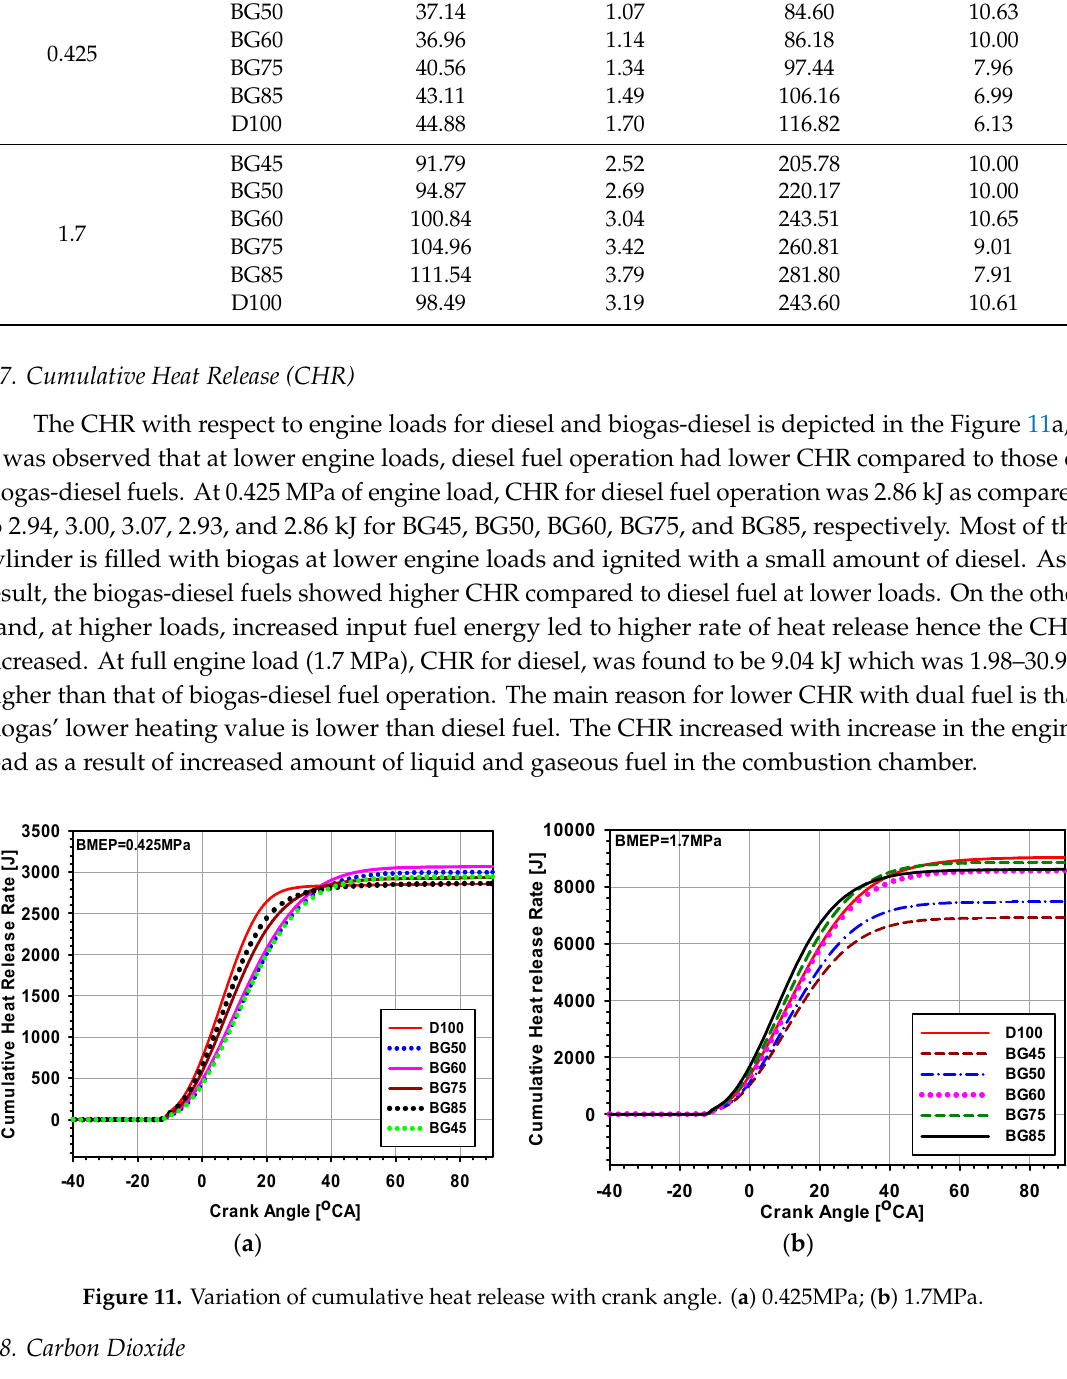
Table 5. Combustion parameters of diesel and biogas-diesel dual fuel operation.